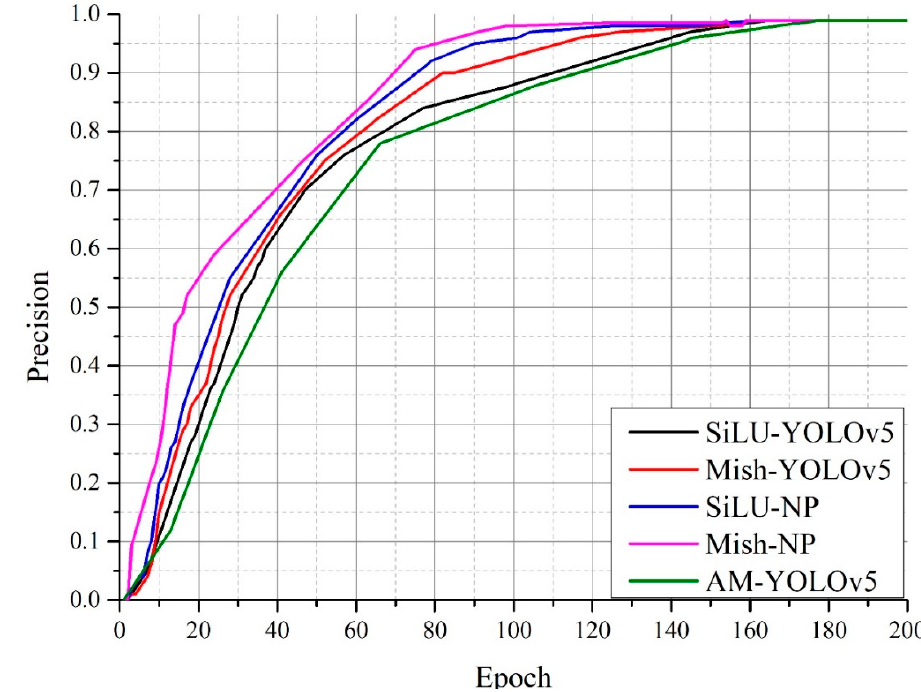
Figure 9. Comparison of the precisions of algorithms.